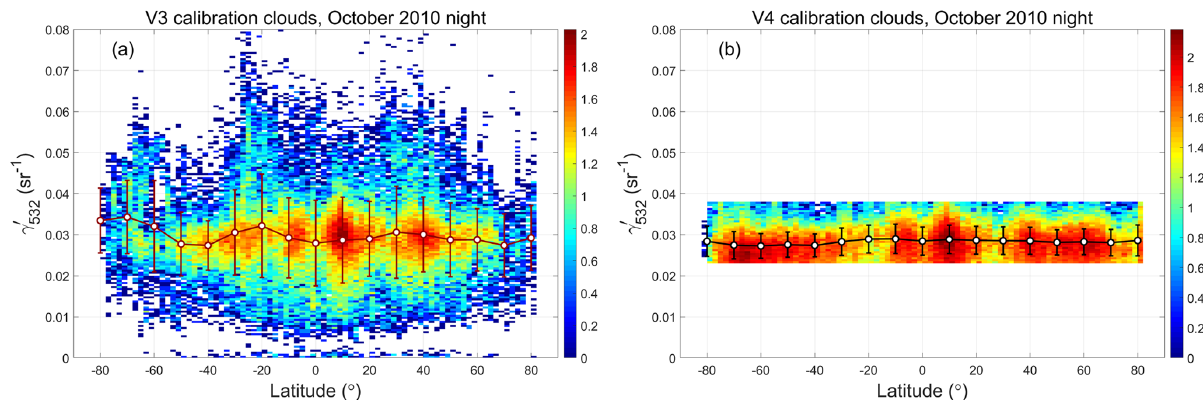
Figure 13. (a) γ (cid:48) for all V3 calibration clouds as a function of latitude, and (b) γ (cid:48) 532 for October 2010 nighttime measurements. The filled circles in each plot represent γ (cid:48) indicate ± 1SD about the means. The colors indicate log 10 of the number of samples in each grid cell.